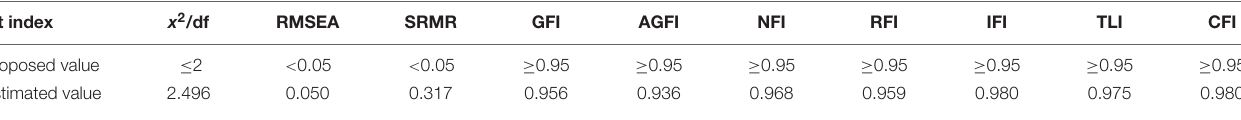
TABLE 5 | Model fit